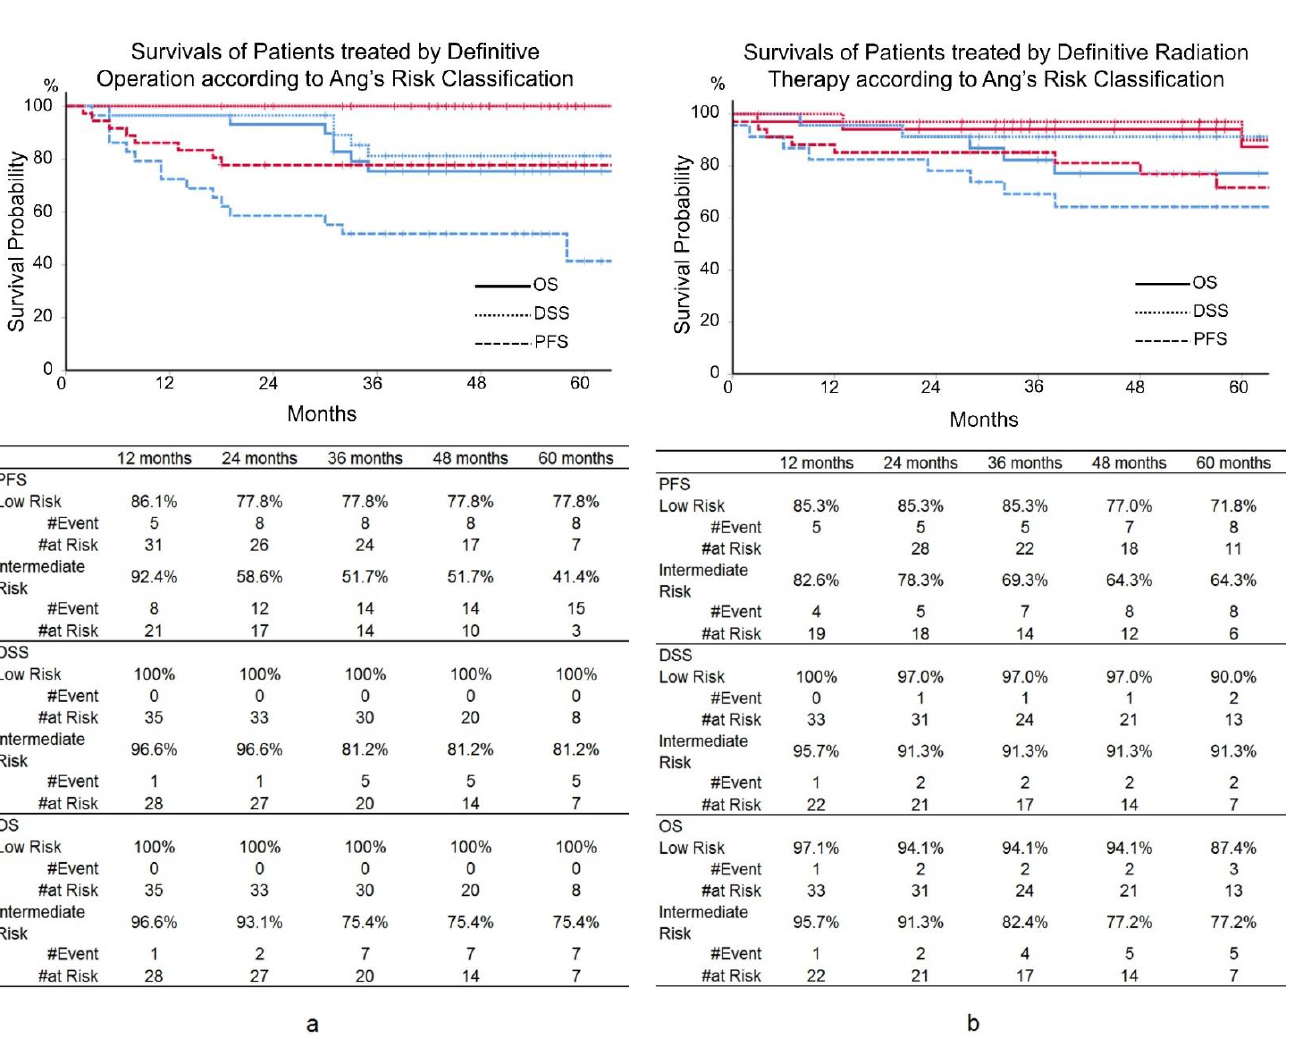
Figure 3. Progression-free survival (PFS), disease-specific survival (DSS), and overall survival (OS) in the patients treated by operation and radiation according to Ang’s risk classification. ( a ) The patients treated by operation. ( b ) The patients treated by definitive radiation. Red line: low risk, blue line: intermediate